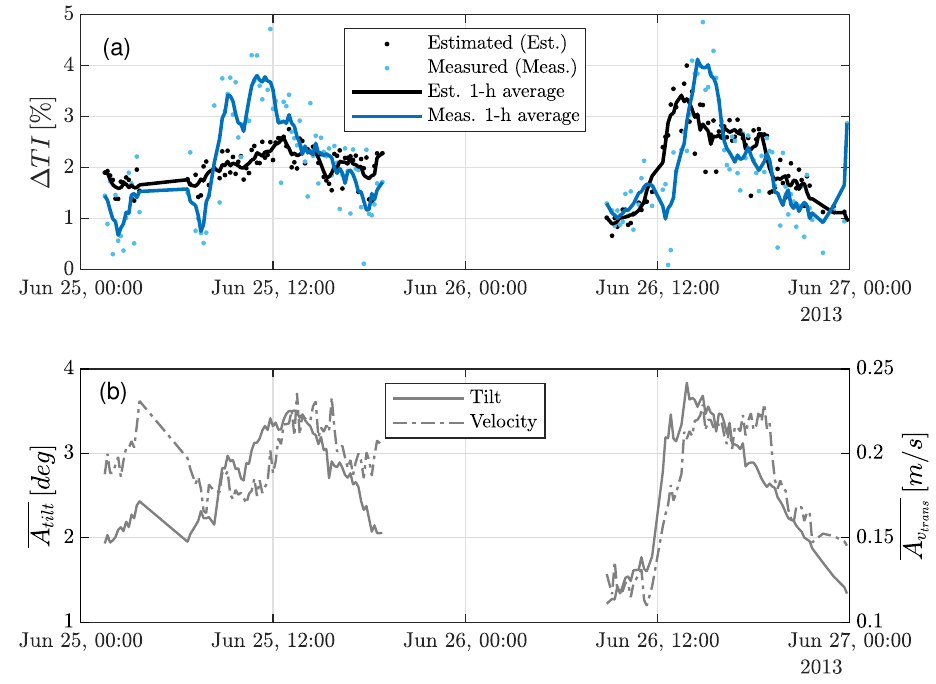
Figure 8. Validation of the analytical-error formulation in a real case scenario (PdP campaign, 25 June 2013, 00:00 UTC to 27 June 2013, 00:00 UTC): TI increment. ( a ) The analytically estimated vs. the measured TI-increment time series. The black dots represent the 10 min analytically estimated TI increment, ∆ TI est (Equation (7)). The blue dots represent the 10 min measured TI increment, ∆ TI meas (Equation (6)). ( b ) The mean tilt amplitude (Equation (34)) and the mean translational-velocity amplitude (Equation (35)) time series. In both panels, the solid trace represents the 1 h averaged time